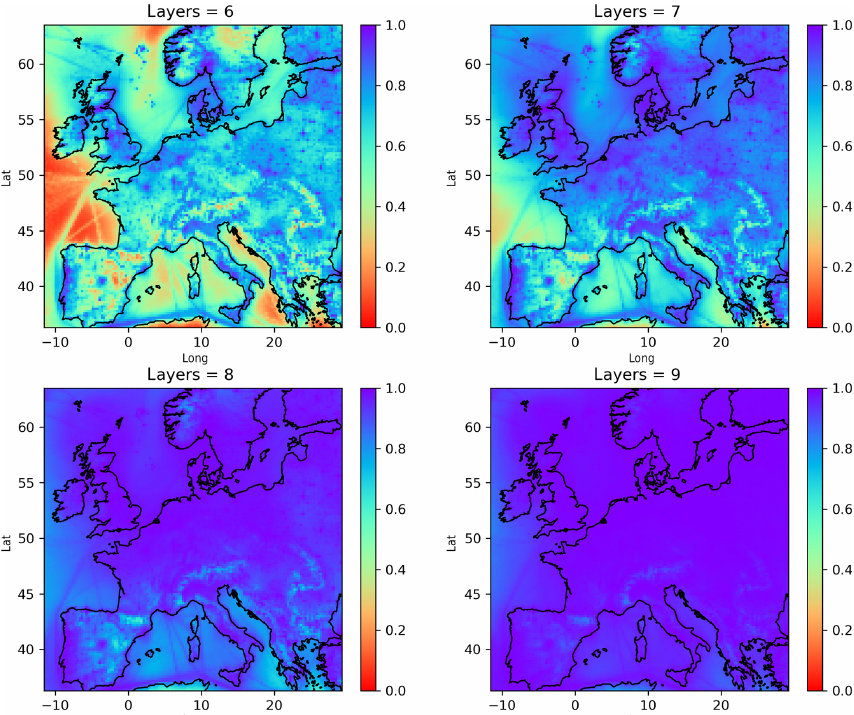
Figure 8. Sum of all local fractions (Eq. 14) for PM 2 . 5 and for different vertical extents of the local region (average for March 2016). A horizontal region of 161 × 161 is included in the local region. For a standard atmosphere, the heights of the top of layers 6, 7, 8 and 9 are respectively 623, 1015, 1522 and 2149m. A sum of 1.0 means that all the sources have been accounted